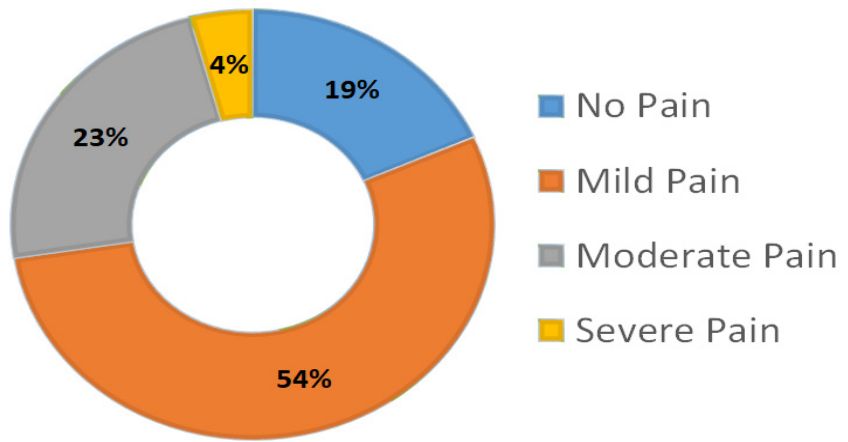
Figure 1. Distribution of Total Neck Disability Index score of the students. Table 4. Number and distribution student functional limitation due to low back pain.